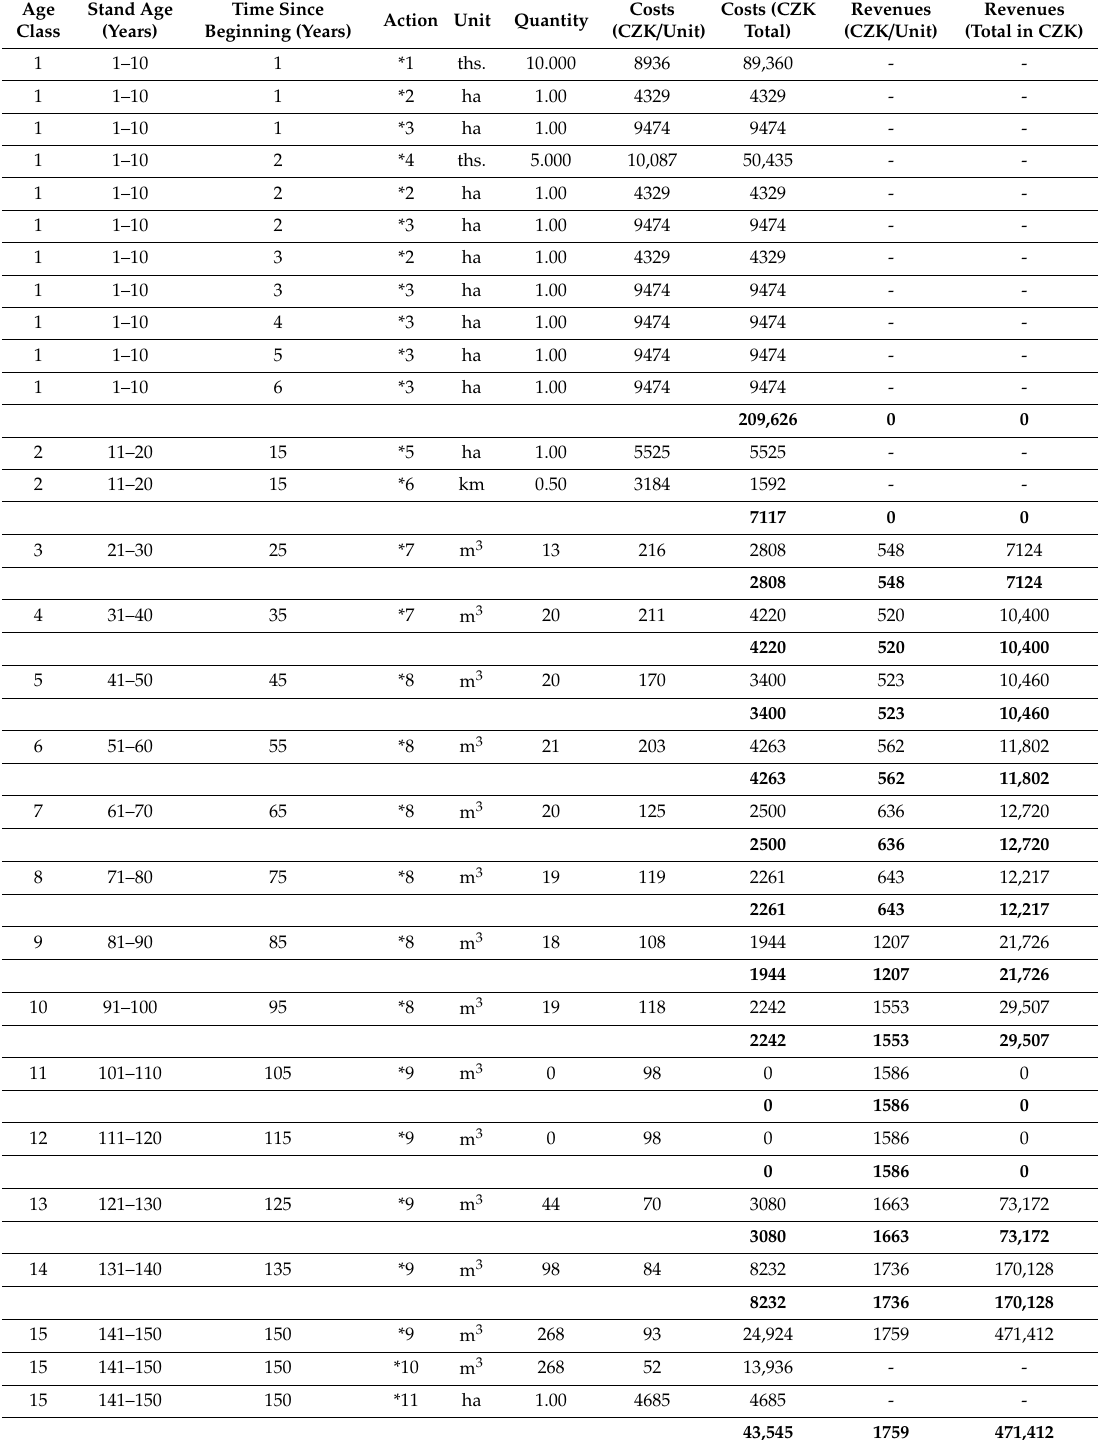
Table 2. Variant: Oak high forest without game-proof